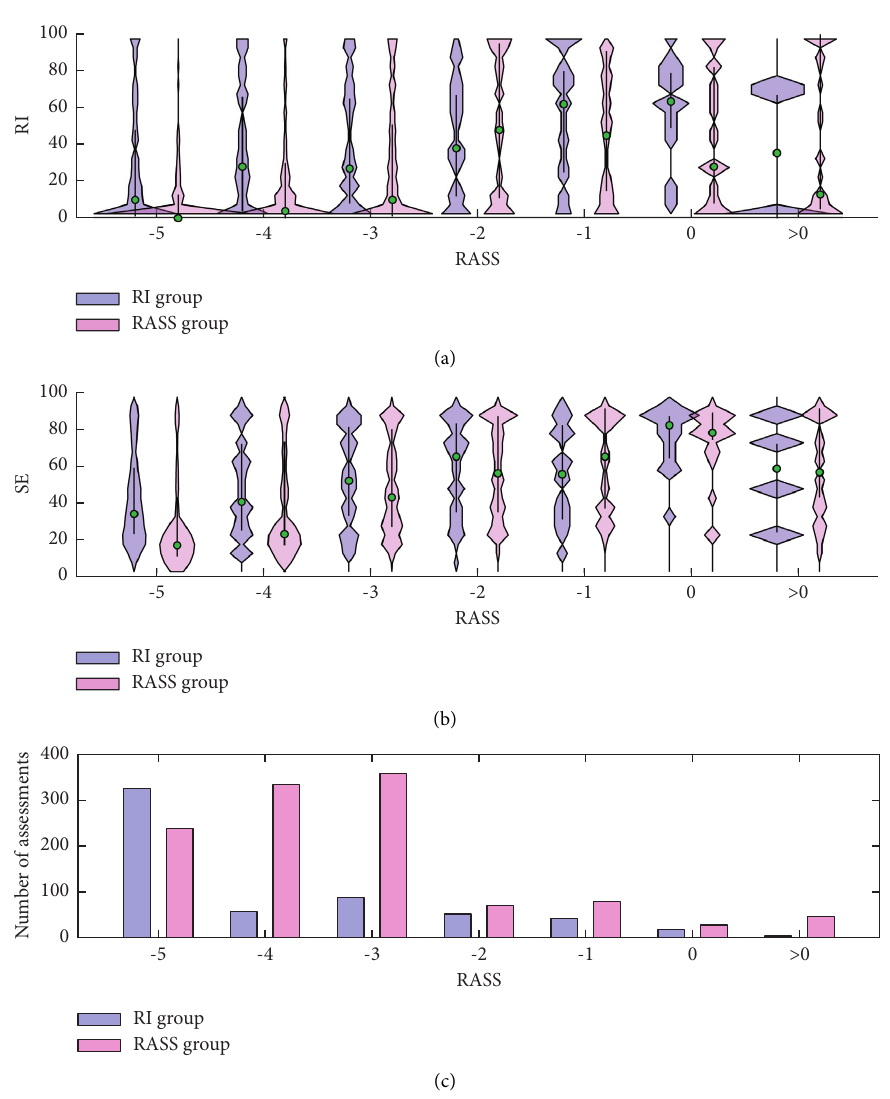
Figure 3: (a) Violin plot presenting RI value distributions at the time of each RASS observation in the RI group (cyan) and in the RASS group (magenta). (b) Violin plots presenting SE value distributions at the time of each RASS observation in the RI group (cyan) and in the RASS group (magenta). (c) Histogram presenting distribution of RASS values in the RI group (cyan) and in the RASS group (magenta). The violin plots present rotated data distribution; i.e., the wider the area is, the more samples are in the range. The thick black line indicates interquartile range, and the green circle is the median. Table 3: RI, SE, and RASS at the time of propofol and oxycodone boluses. RI group RASS group p